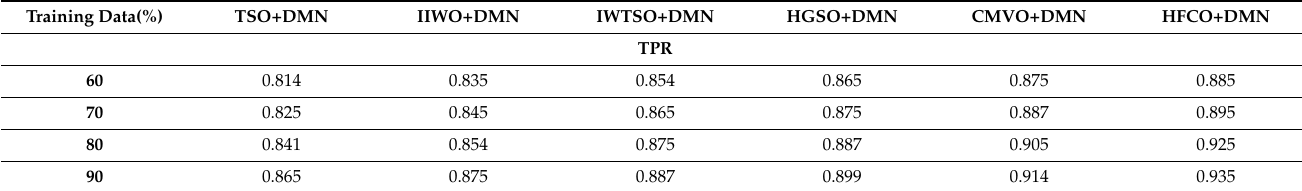
Table 8. Analysis based on optimization using Reuter dataset for TPR, TNR, FNR, precision, and testing